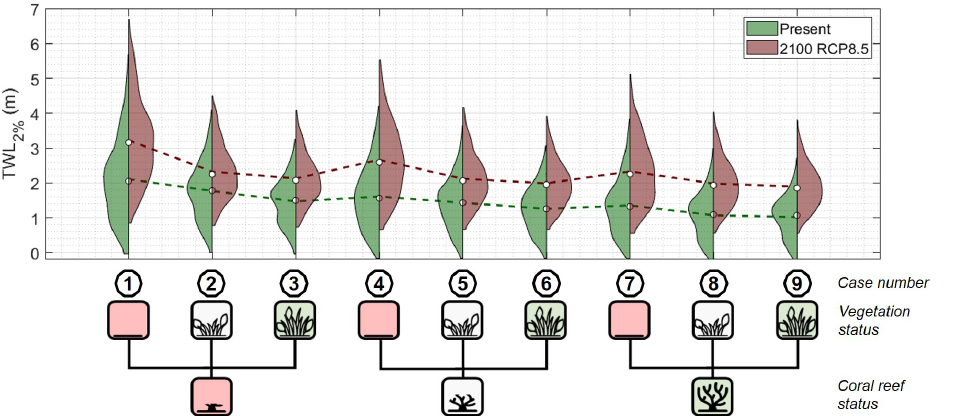
Figure 10. TWL distribution for each ecosystem configuration for present day and sea-level scenario RCP8.5 for